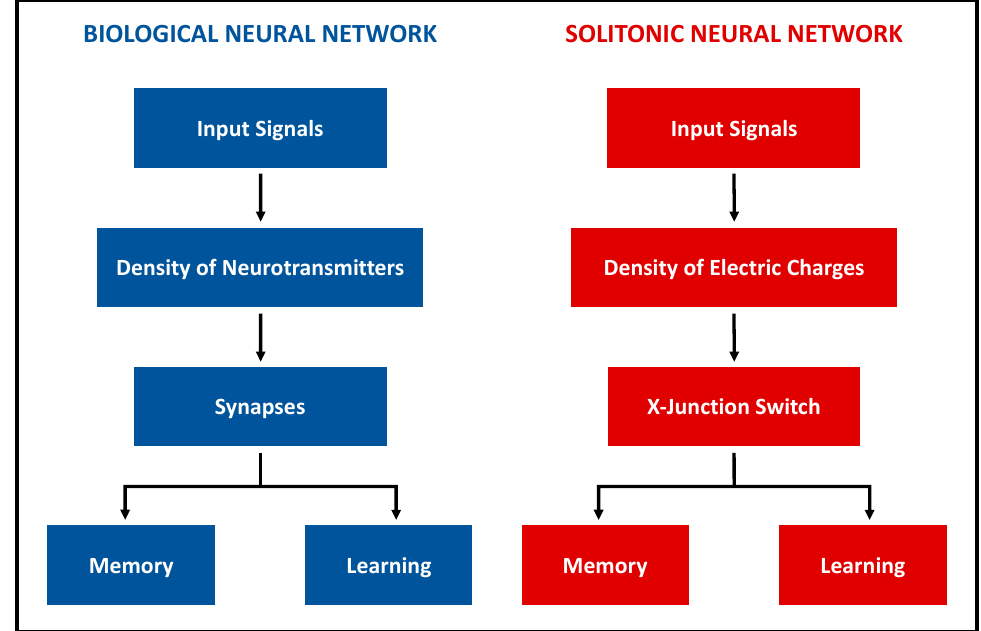
Figure 1. Diagram of the functional parallelism between BNNs and SNNs. Both systems are able to modify their structure, to process the incoming information and to store them. The structural variations are due, in the biological case, to variations in the density of neurotransmitters, while in the solitonic case in the density of electrical charges.